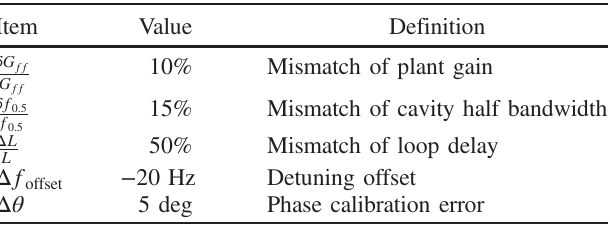
TABLE II. Assumptions in the analytical study.